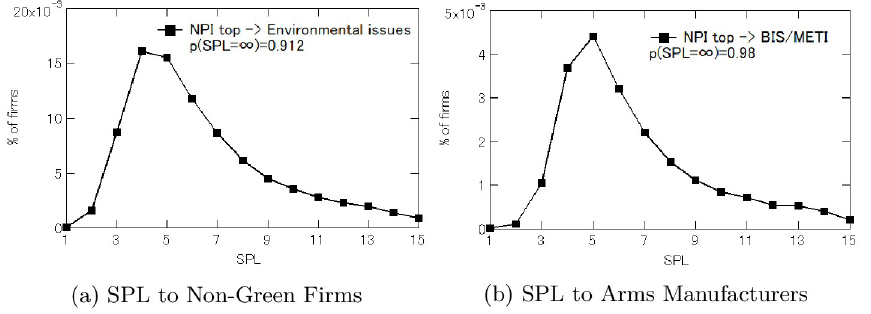
Fig 2. Degrees of separation between top 10K NPI ultimate owners and non-ESG